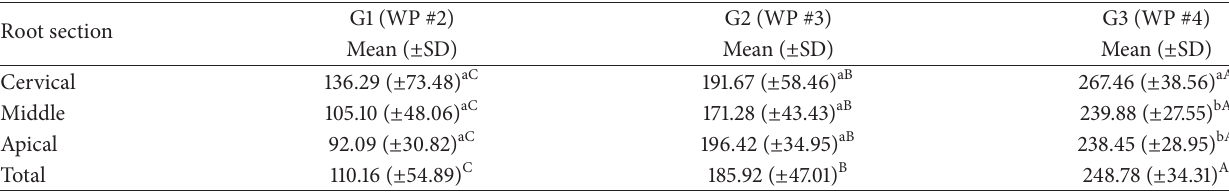
Figure 3: (a) Adhesive fracture between resin cement and dentin. (b) Adhesive fracture between resin cement and fiber post. (c) Mixed fracture. Table 1: Cement film thickness by drill size and location of root section ( 𝜇 m).